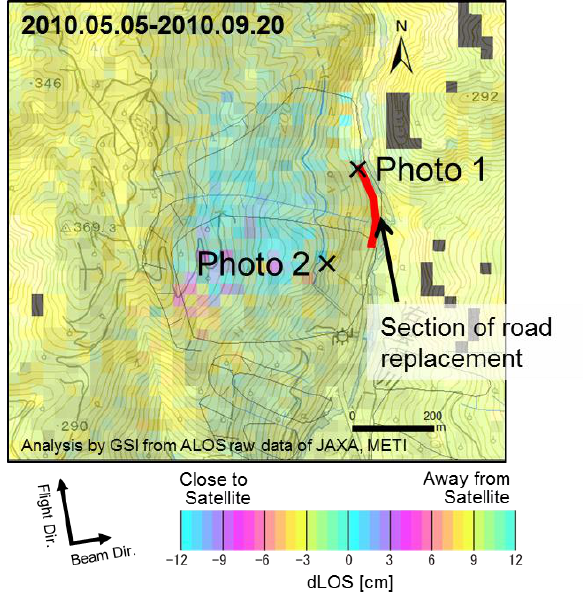
Figure 4. InSAR imagery between May 5, 2010 and September 20, 2010 on GSI Maps in Tanabe site.